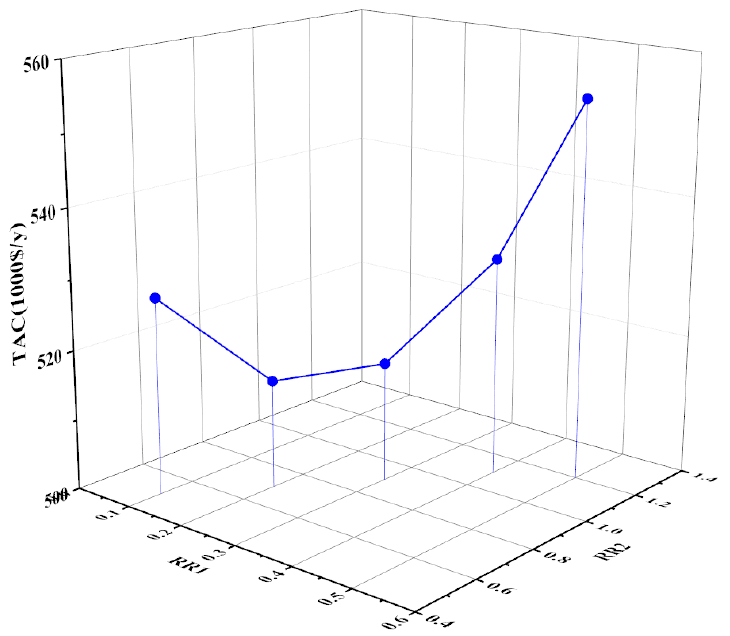
Figure 6. Effect of the reflux ratios of two columns on the total annual cost (TAC).